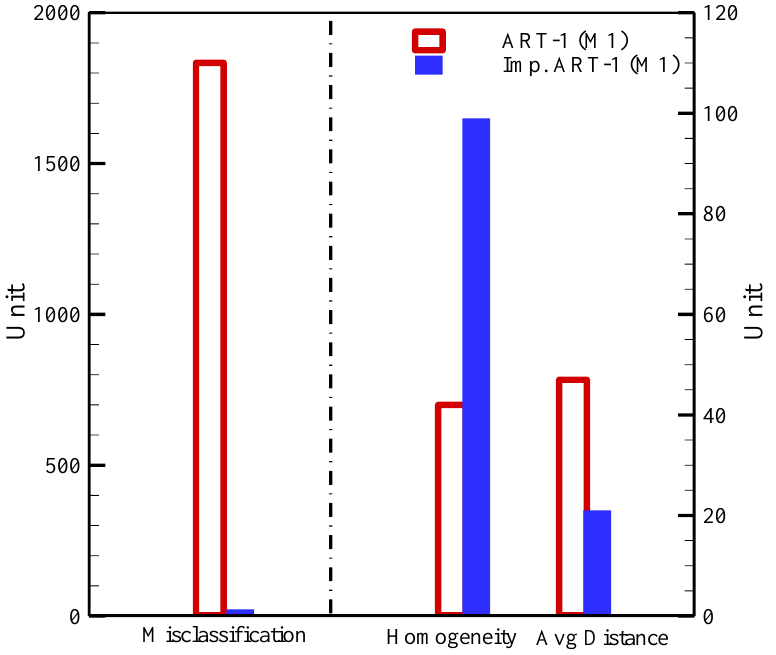
Figure 4. Comparative study between Improved-ART-1 and ART-1 considering